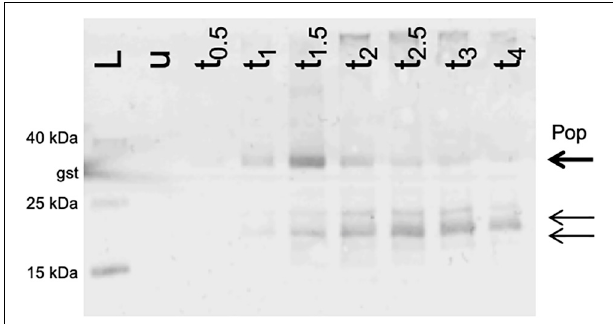
FIGURE 6 | Western blot of Pop protein. Expression of pop in frame with a C-terminal SPA-tag. Cells were grown in LB at pH 7.4 and harvested before induction and up to 4 h after induction (t x ) and normalized cell numbers were separated on 16% tricine gels. The arrows indicate the band of the putative full-length protein Pop (bold arrow) and two shorter products (thin arrows). The experiment was conducted in LB at pH 7.4. L, Spectra Multicolor Low Range Protein Ladder (Thermo Scientific) with additional internal Western blot control glutathione-S-transferase (band sizes are indicated); u , whole cell extract from uninduced cells; t x , whole cell extract from samples harvested after x = 0.5, 1, 1.5, 2, 2.5, 3, and 4 h after induction with